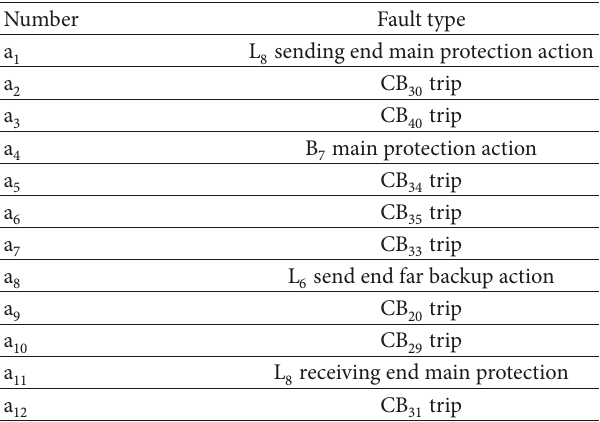
Table 8: The code of alarm